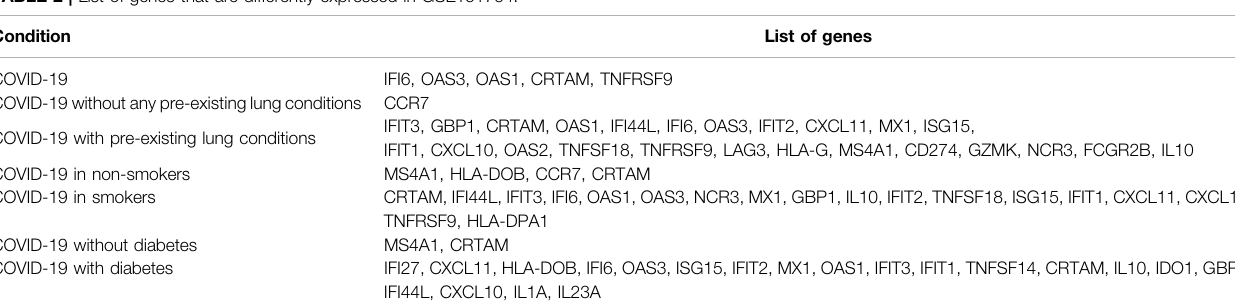
TABLE 2 | List of genes that are differently expressed in GSE151764.